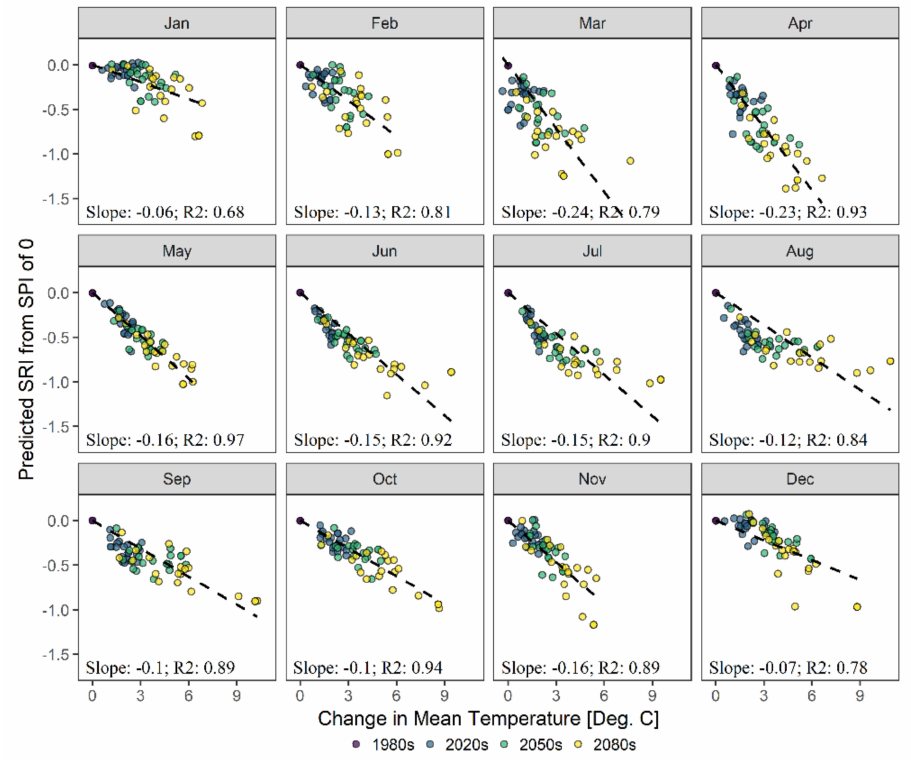
Figure 8. Climate warming impact on the relationship between SPI and SRI. Linear slope represents the change in standardized drought index per ◦ C change in mean monthly temperature. Change in mean temperature is a significant predictor ( p < 0.01) for all